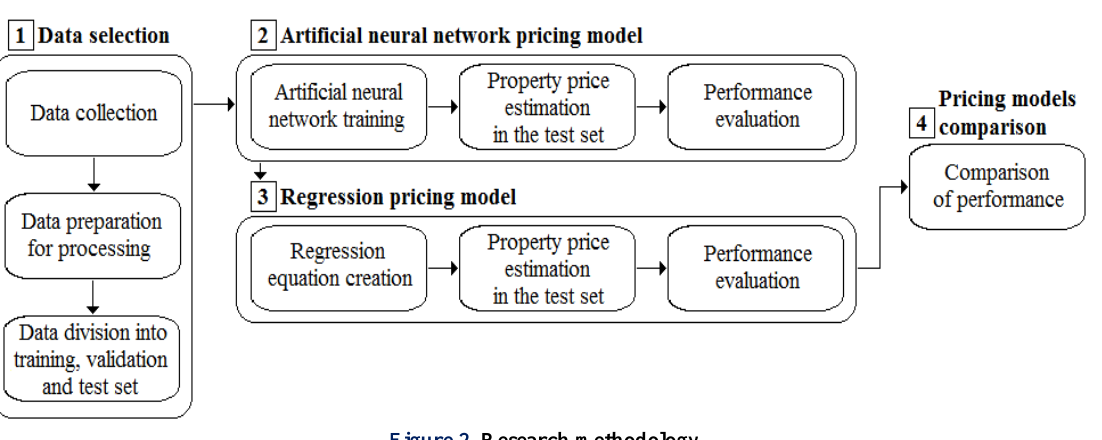
Figure 2. Research